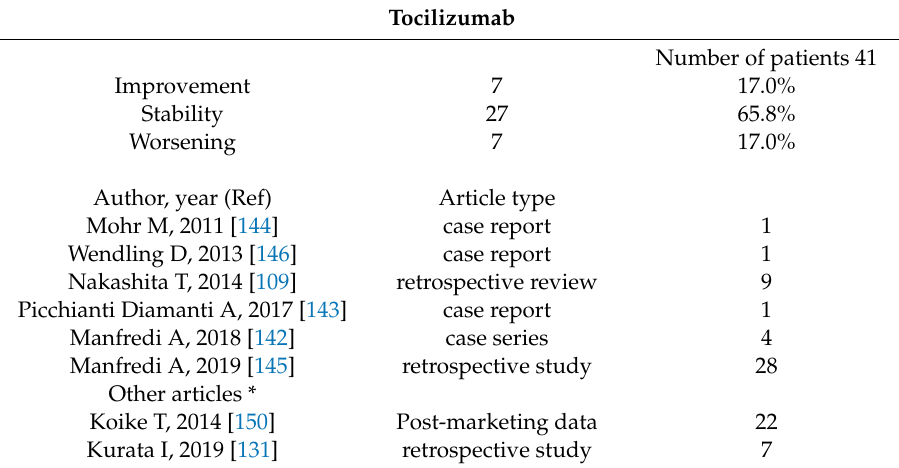
Table 6. Pulmonary e ff ects of tocilizumab in RA-ILD patients: a review of the literature.